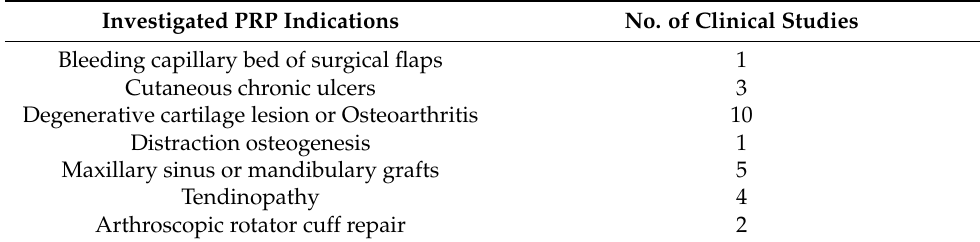
Table 5. PRP indications investigated among top-cited clinical studies.